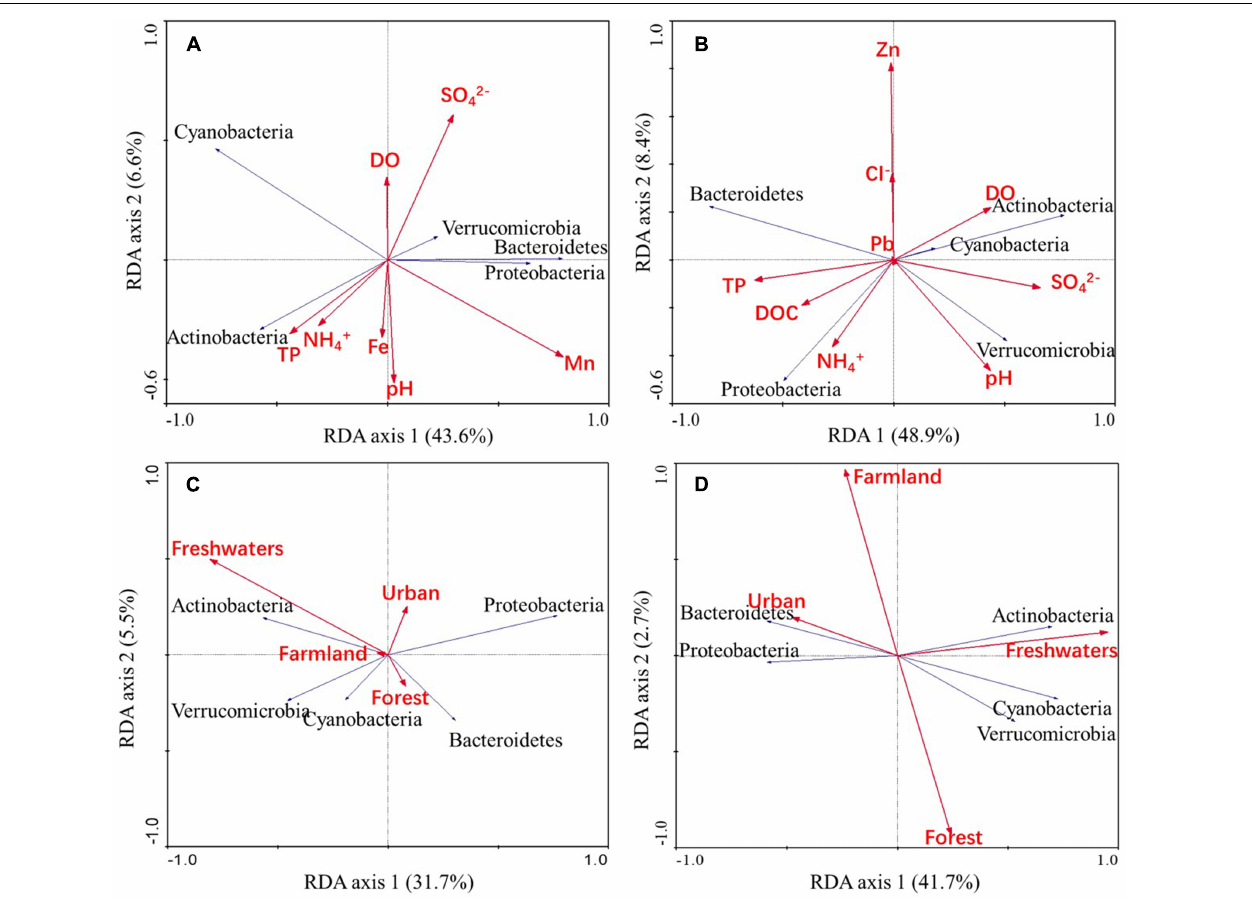
FIGURE 5 | RDA ordinations showing bacterioplankton community variation in relation to water chemistry parameters and land use types. The abundances of predominant phyla in the bacterioplankton communities were related to water chemistry parameters in wet (A) and dry (B) season samples and were also related to land use patterns in wet (C) and dry (D) season